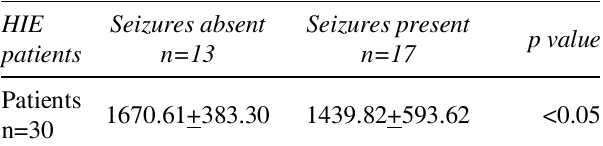
Table 2: Total antioxidant level (µmol/L) in hypoxic ischemic encephalopathy (HIE) with seizures.